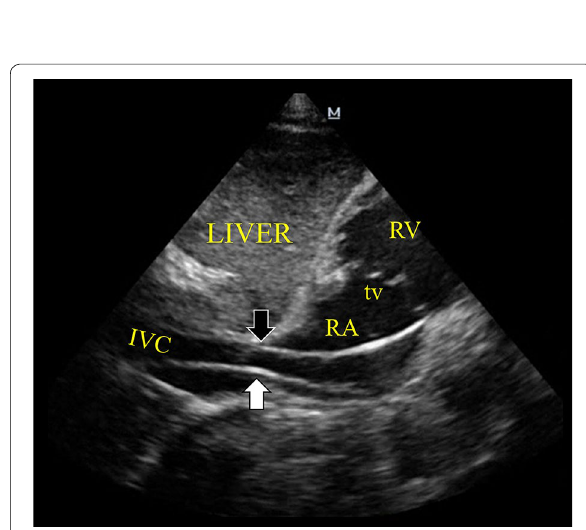
Fig. 2 Subcostal inferior vena cava (IVC) view demonstrating the EC entering (white arrow) and getting out (black arrow) the IVC in direction of the right heart chambers. RA right atrium, tv tricuspid valve, RV right